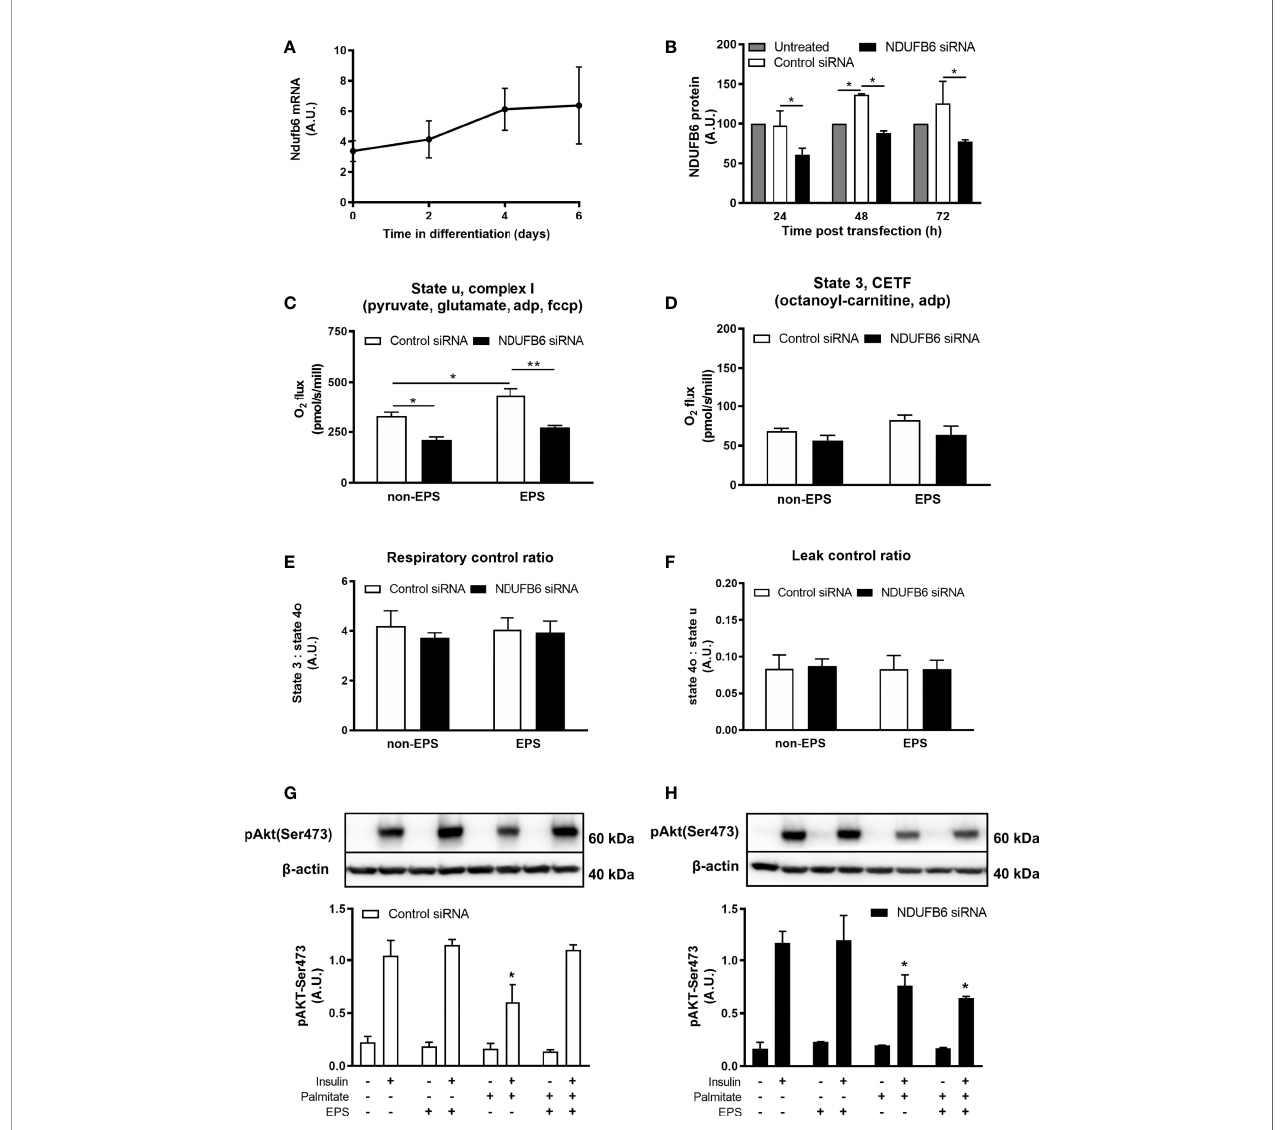
FIGURE 3 | Ndufb6 expression after siRNA silencing and effects of the Ndufb6 silencing on mitochondrial function in differentiated C2C12 myotubes after EPS- induced contractions. Ndufb6 expression during differentiation of C2C12 myocytes (A) and protein levels (B) after siRNA silencing. Ndufb6 protein levels were normalized to GAPDH. State u, complex I-linked (C) respiration and electron-transferring fl avoprotein complex (CETF)-linked (D) respiration as well as respiratory control ratio (E) and leak control ratio (F) were assessed at the basal (non-EPS) and EPS-induced contractions; an independent samples t-test was used for group- comparison. Insulin-stimulated Akt phosphorylation at Ser473 (pAkt-Ser473) after palmitate incubation and electric pulse stimulation (EPS)-induced contractions in differentiated C2C12 myotubes treated with control siRNA (G) or NDUFB6 siRNA (H) ; Data are expressed as mean ± SEM (n=3-4/group), *p < 0.05 and **p < 0.01 vs. corresponding basal and control or untreated